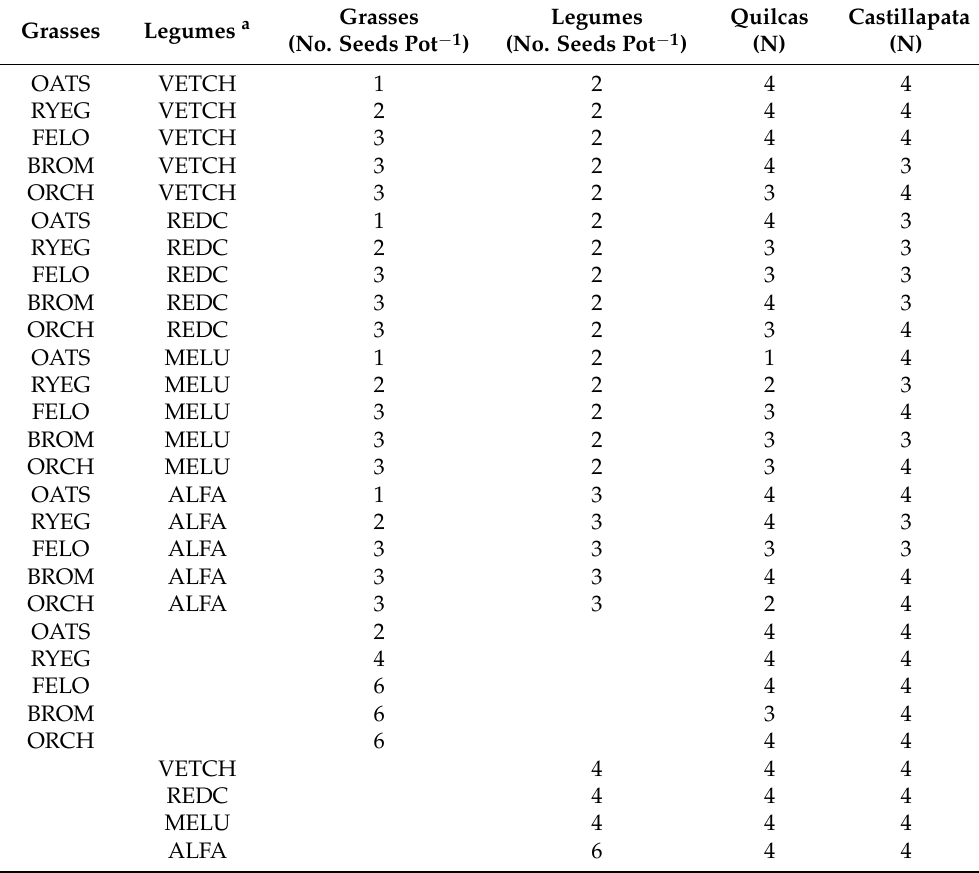
Table 2. Seeding rate for grass–legume bicultures and monocultures planted in November 2014 as well as the number of successful repetitions considered for statistical analyses in each treatment.